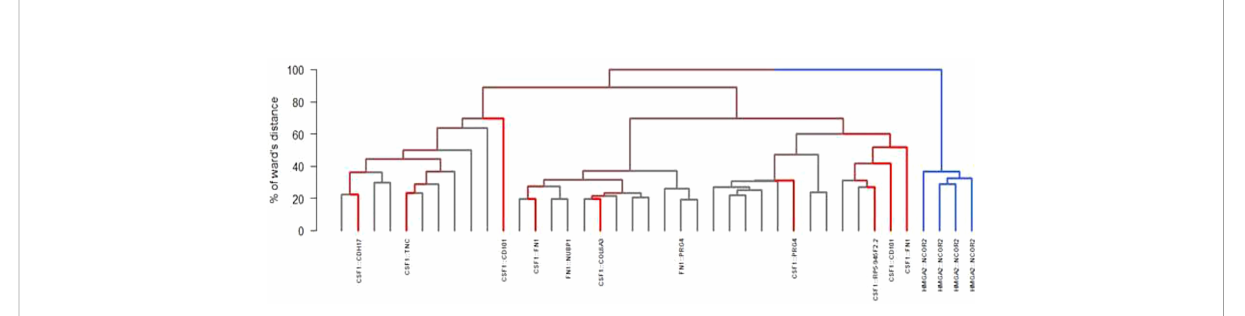
FIGURE 3 Different fusions found by RNA sequencing and hierchical ascending clustering of RNA sequencing (in blue: HMGA2::NCOR2 fusion; in red: non-HMGA2::NCOR2 fusion; in grey: no fusion detected).